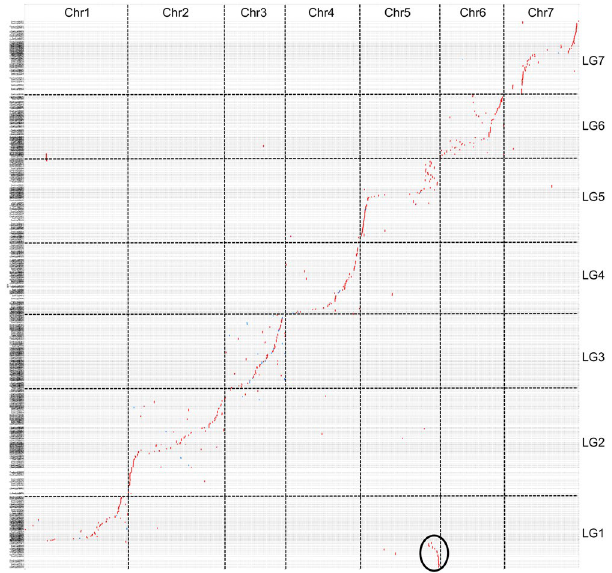
Figure 5. Dot plot representing collinearity between Lens culinaris pseudomolecules 1 through 7 (X-axis) and L. ervoides linkage groups 1 through 7 (Y-axis). A translocation between L. culinaris pseudomolecules 1 and 5 is circled.